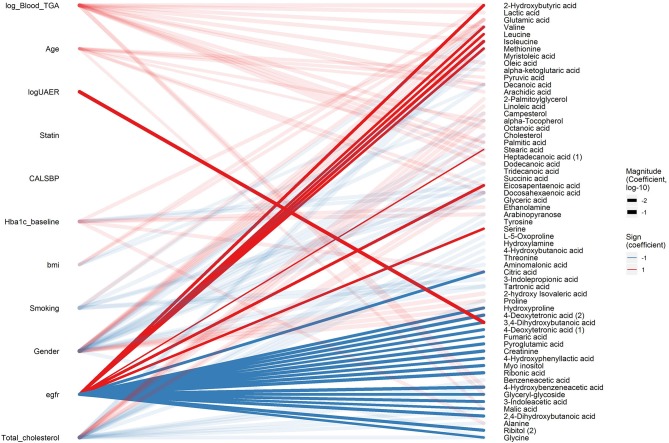
Cross-sectional associations between metabolites and clinical variables. Associations with pBH < 0.05 between clinical variables (left) and metabolites (right) are shown in a bipartite network. Sign of the coefficient is shown in color (red and blue for positive and inverse association, respectively) and magnitude of the coefficient is shown in the width of the line. Associations related to eGFR and logUAER are highlighted with opaque lines while other associations are shown in transparent lines.